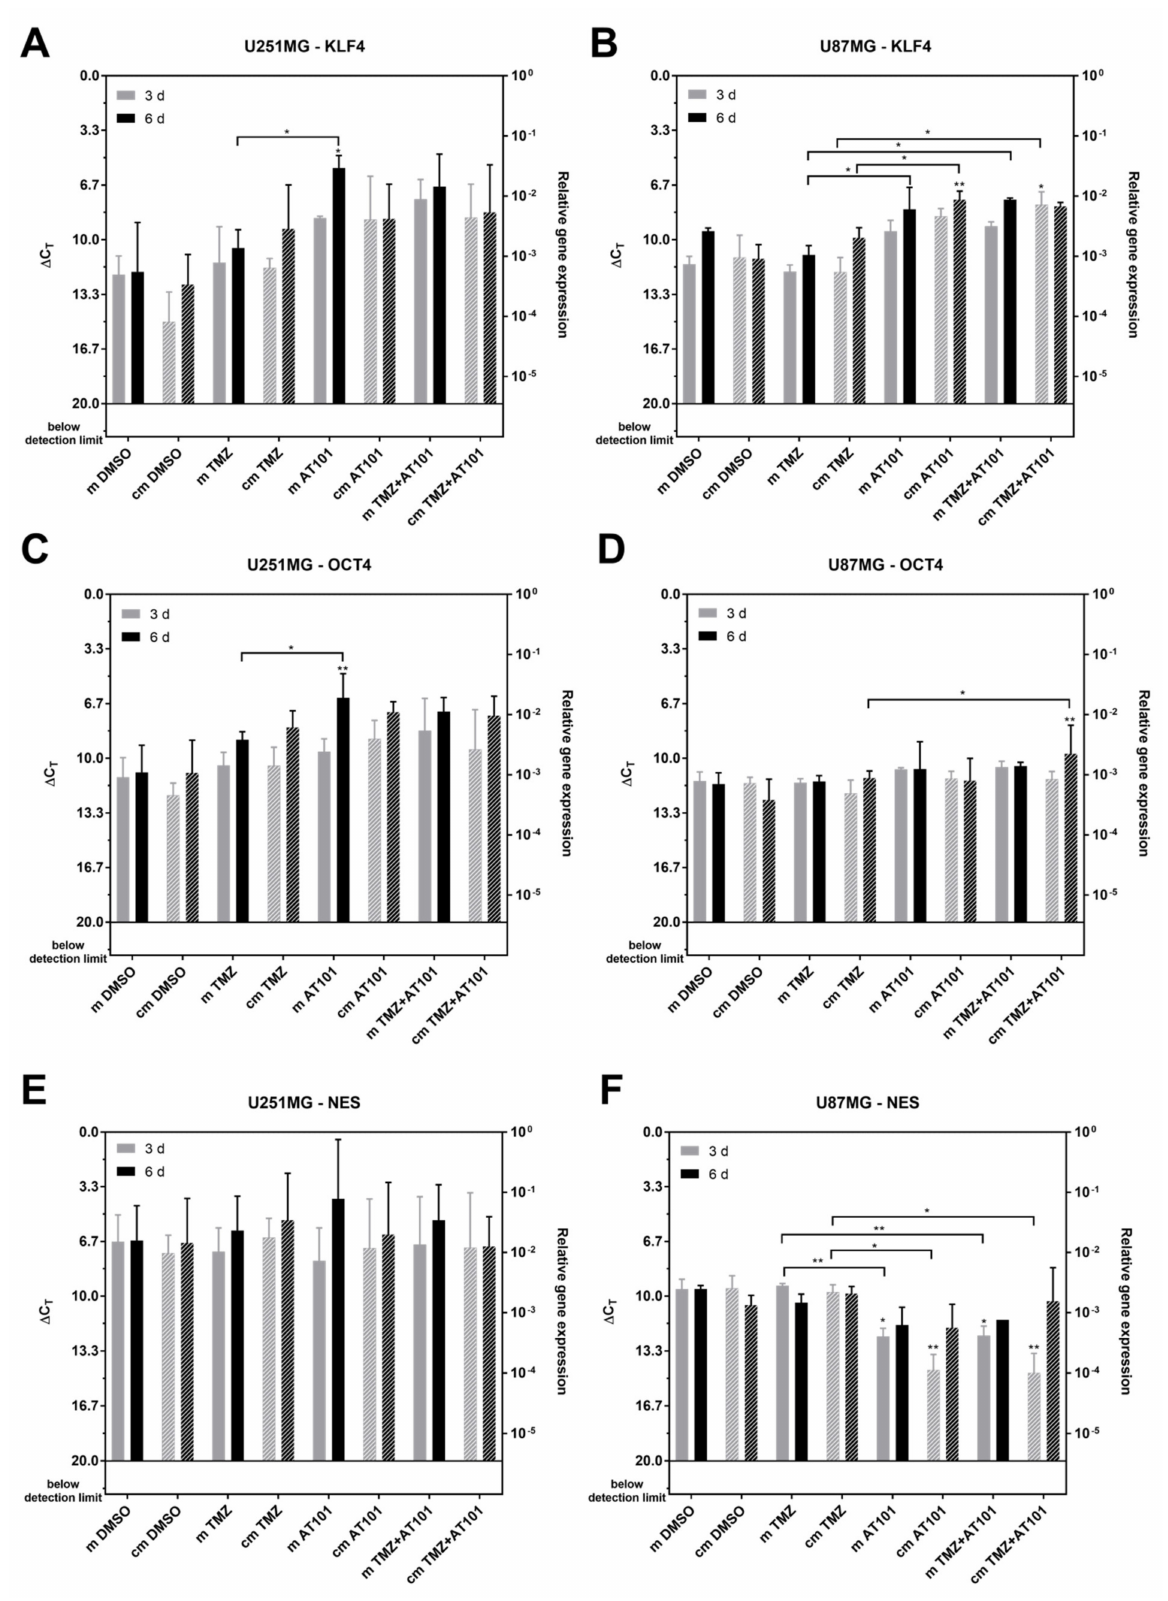
Figure 5. Quantitative PCR (qPCR) analysis of the messenger RNA (mRNA) expression of the different stem cell markers krüppel-like factor 4 (KLF4), octamer binding transcription factor 4 (OCT4), and Nestin (Nes) in native U251MG and